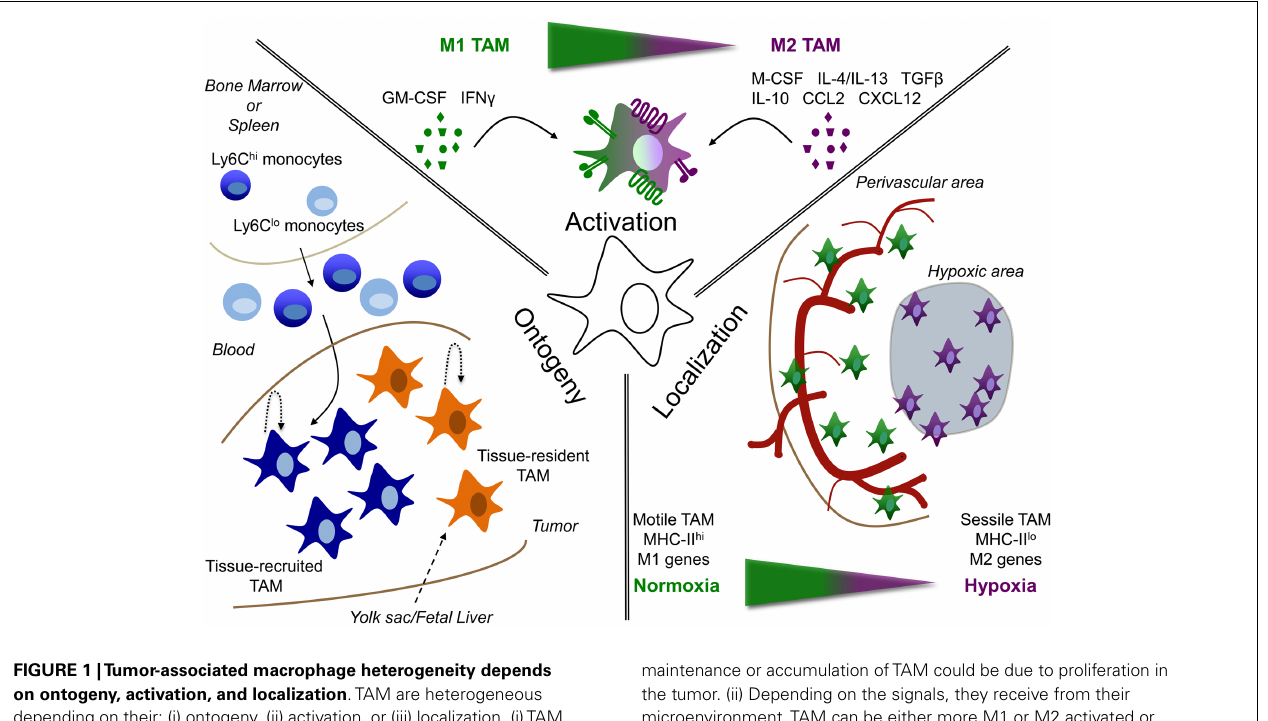
FIGURE 1 |Tumor-associated macrophage heterogeneity depends on ontogeny, activation, and localization .TAM are heterogeneous depending on their: (i) ontogeny, (ii) activation, or (iii) localization. (i)TAM could either be derived from the self-renewing tissue-resident macrophage pool (tissue-residentTAM), whose precursors are formed early in life in the yolk sac or fetal liver; or can be derived from circulating monocytes, termed tissue-recruitedTAM. In addition,